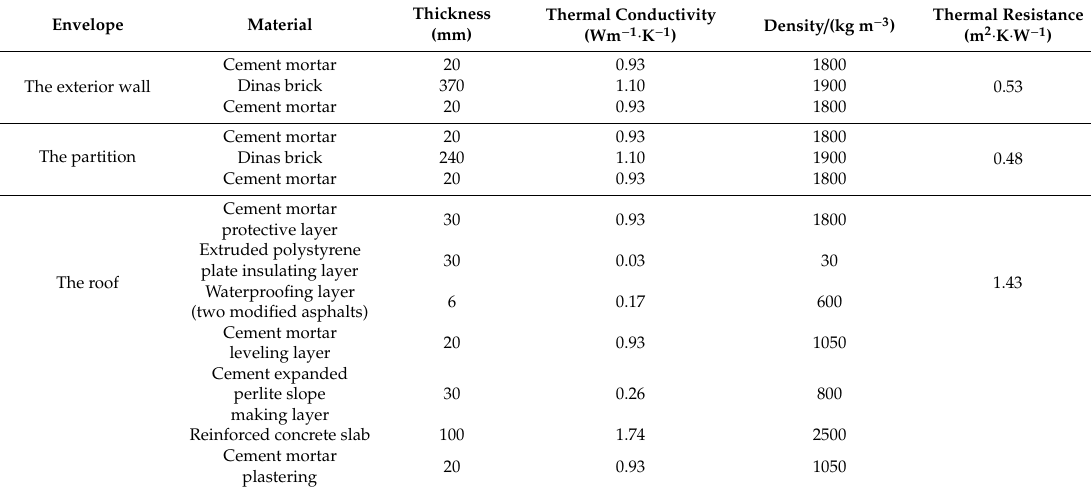
Table 3. Component and thermal parameters of the building envelope.